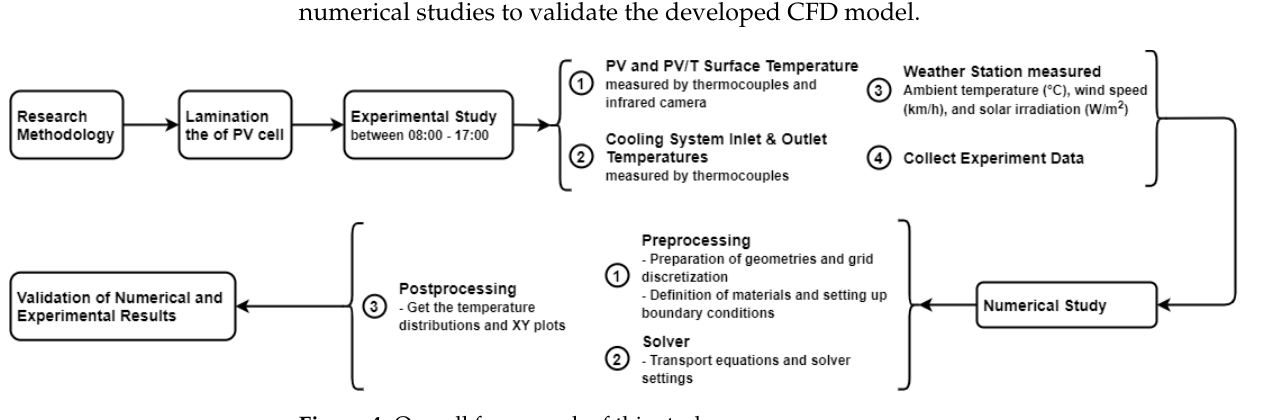
Figure 4. Overall framework of this study.